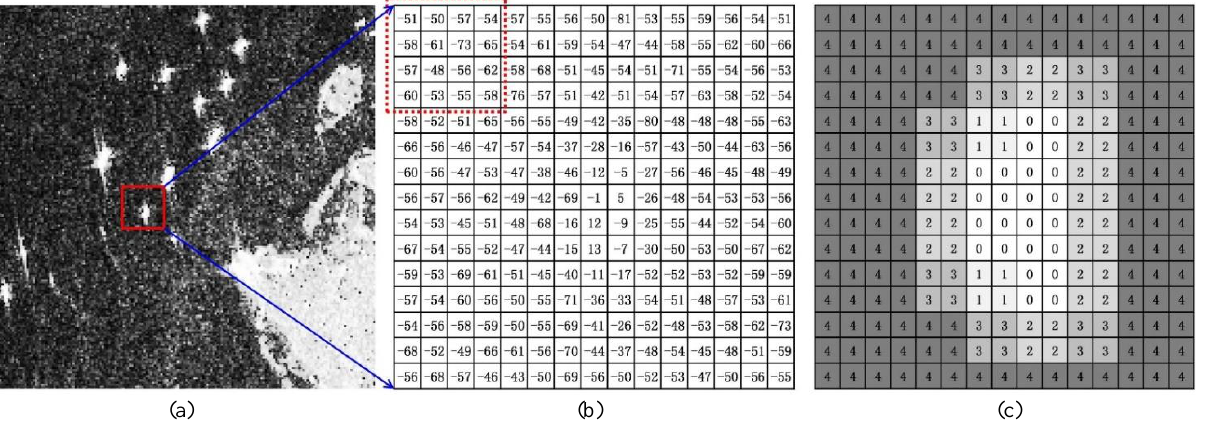
Fig. 3 Schematic diagram of sliding window for the labeling of water pixels, where (a) presents the backscattering coefficient images, (b) present the backscattering intensity value and the sliding window, (c) presents the number of marks for each